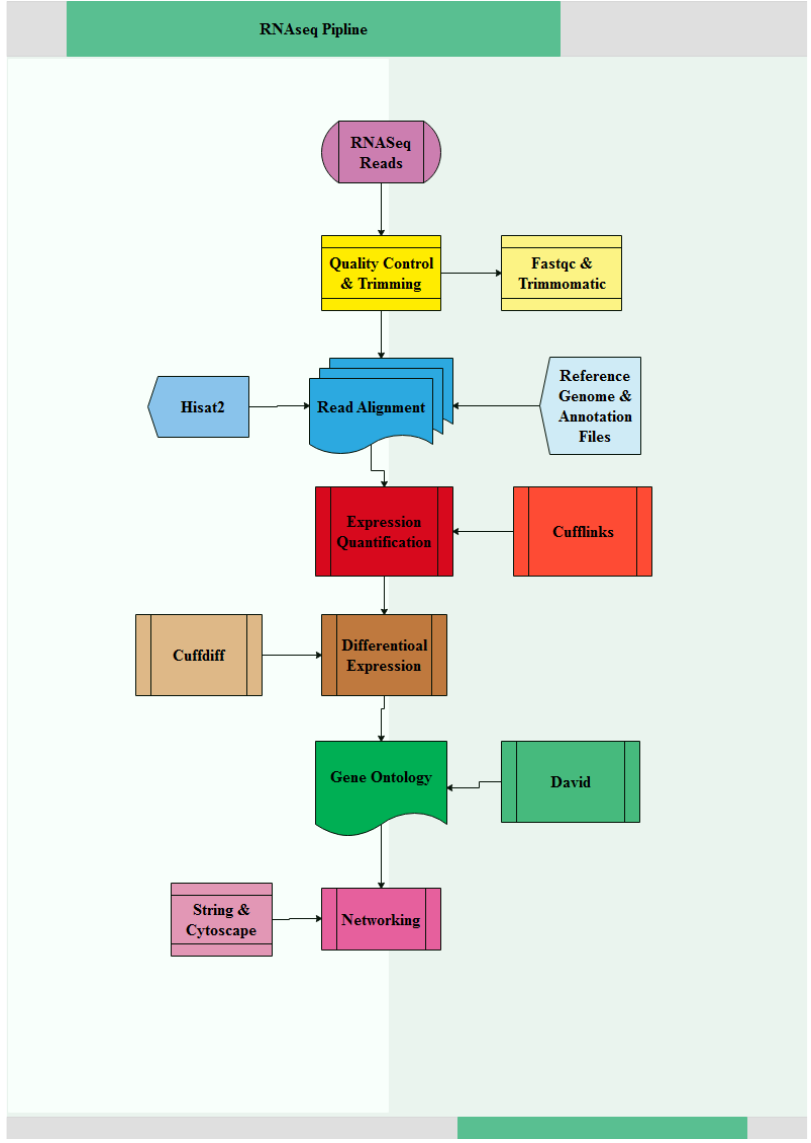
Figure 1. The methodology pipeline used in this study. Table 2. Summary of sequence-read alignments to the reference genome. Table 3. Upregulated and downregulated genes between indigenous and commercial birds (upregu- lated genes were more highly expressed in commercial